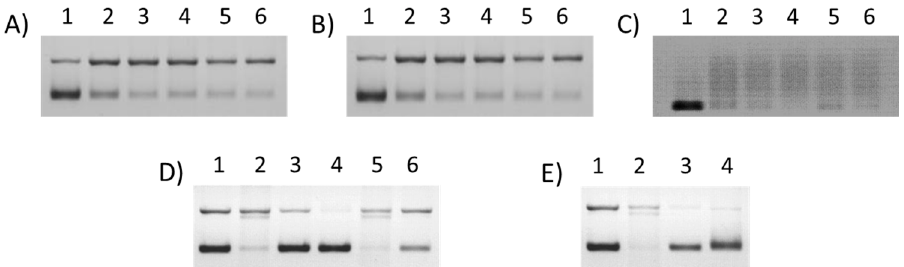
Figure 2. ( A ) Concentration-dependent DNA cleavage by 3 after 20 h incubation. Lane 1: DNA only; Lanes 2–6: DNA + 2, 5, 10, 15, and 20 µM of 3 . ( B ) Effect of ascorbic acid on 3 -mediated DNA cleavage after 20 h incubation. Lane 1: DNA only; Lanes 2–6: DNA + 2, 5, 10, 15, and 20 µM of 3 with 10 equivalents of ascorbic acid. ( C ) Effect of glutathione on 3 -mediated DNA cleavage after 20 h incubation. Lane 1: DNA only; Lanes 2–6: DNA + 2, 5, 10, 15, and 20 µM of 3 with 10 equivalents of glutathione. ( D ) Inhibition of 3 -mediated DNA cleavage by reactive oxygen species (ROS) scavengers after 20 h incubation. Lane 1: DNA only; Lane 2: DNA + 3 (10 µM); Lanes 3–6: DNA + 3 (10 µM) + NaN 3 (40 mM), KI (40 mM), DMSO (10 mM), or t BuOH (10 mM). ( E ) Inhibition of 3 -mediated DNA cleavage by DNA minor and major groove binders after 20 h incubation. Lane 1: DNA only; Lane 2: DNA + 3 (10 µM); Lane 3: DNA + 3 (10 µM) + methyl green (50 µM); Lane 4: DNA + 3 (10 µM) + DAPI (50 µM).